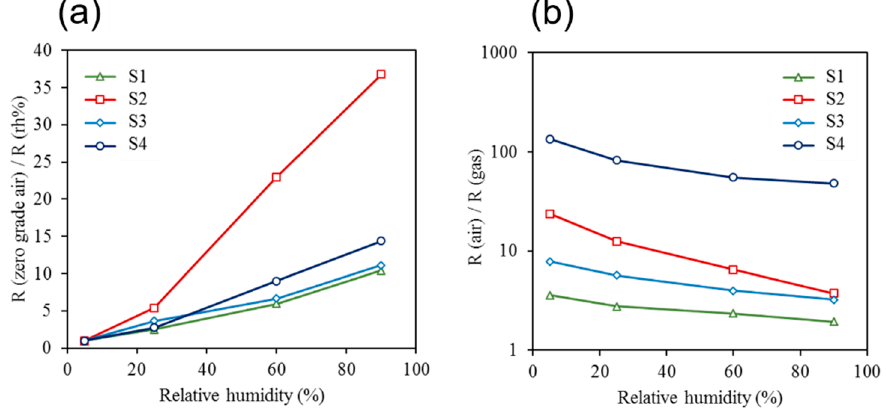
Figure 18. ( a ) Responses of sensors S1–S4 to different relative humidity levels and ( b ) the responses of the sensors S1–S4 to 0.5 ppb of benzene under different humidity conditions.